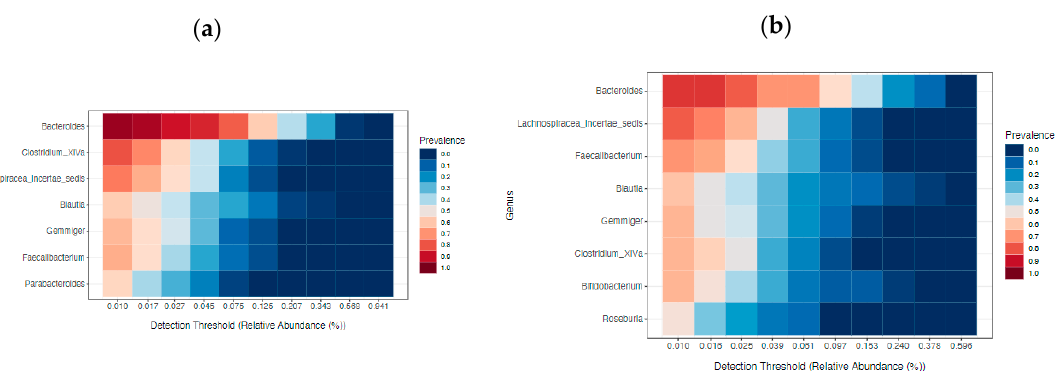
Figure 6. Heatmap of the core microbiome: the overall core microbiome of stool and tumor between RSCC ( a ) and LSCC patients clustered differentially ( b ).